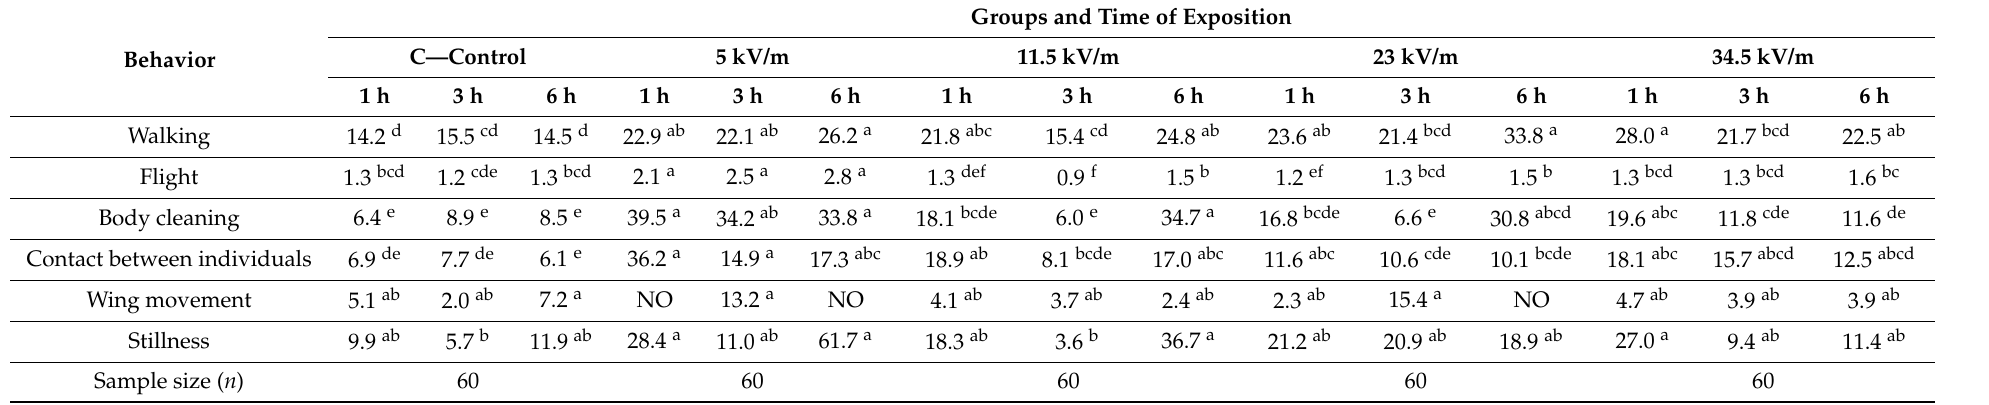
Table 2. Comparison of the mean duration as a function of exposition time and E-field intensity in and between all